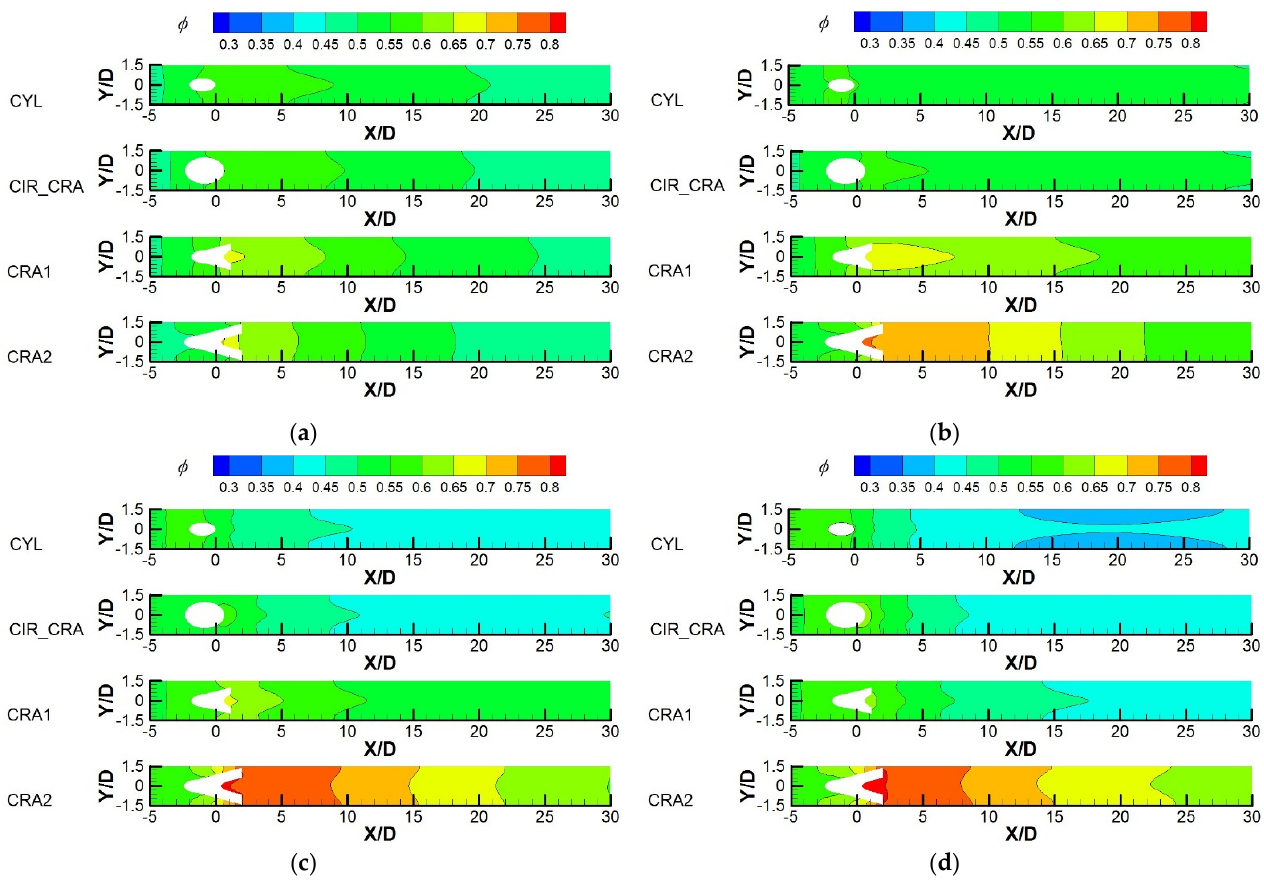
Figure 9. Local overall cooling effectiveness over the wall surface at various blowing ratios. ( a ) M = 0.5; ( b ) M = 1.0; ( c ) M = 1.5; ( d ) M = 2.0. ( a ) M = 0.5; ( b ) M = 1.0; ( c ) M = 1.5; ( d ) M =